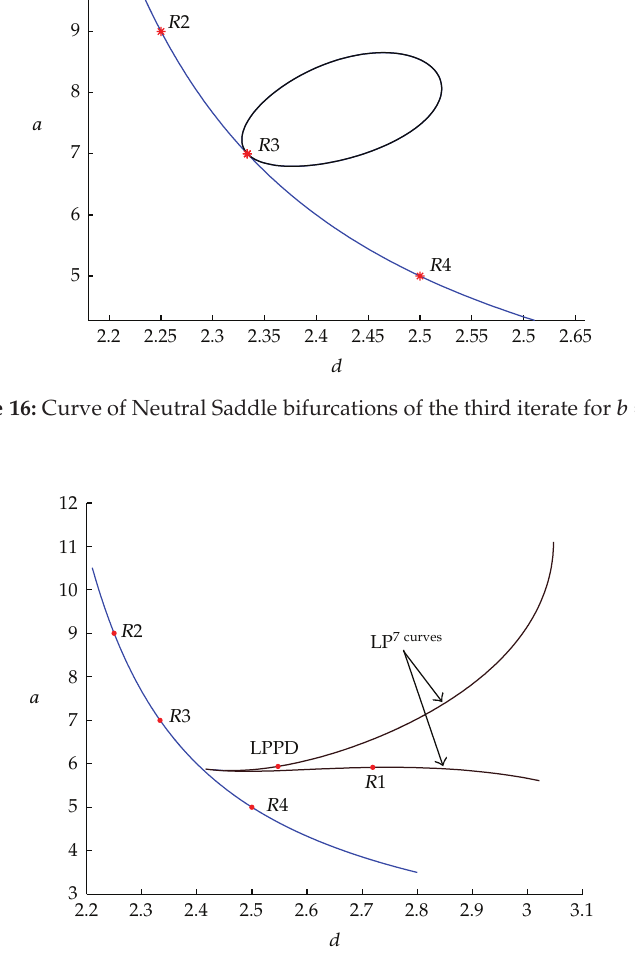
Figure 17: An Arnold tongue rooted in a weak 2: 7 resonant Neimark-Sacker